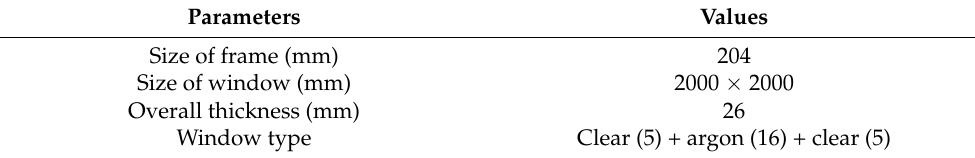
Table 2. Window specifications.